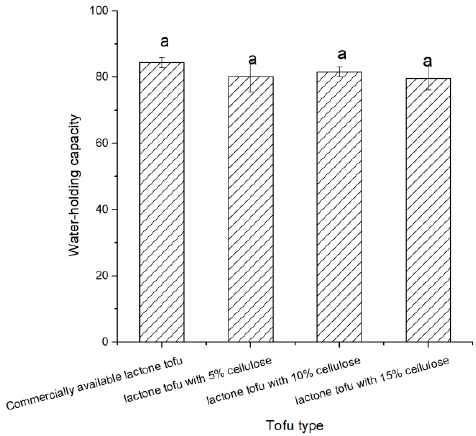
Figure 2. Comparison of the water-holding capacities of the different types of tofu.